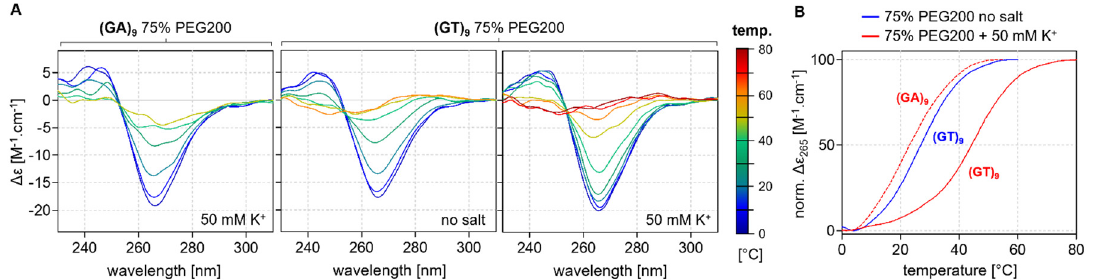
Figure 4. ( A ) CD profiles of (GA) 9 and (GT) 9 in the presence and absence of PEG200 obtained at different temperatures with increments of 10 ◦ C; ( B ) Dependence of the negative peak at 265 nm on PEG200 concentration.